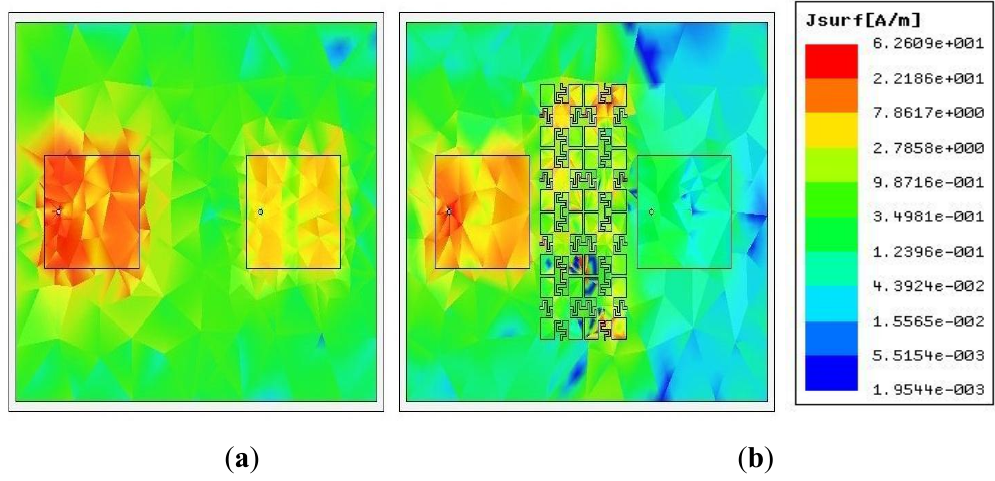
Figure 10. Snapshots of the surface current distribution ( a ) reference array; ( b ) with